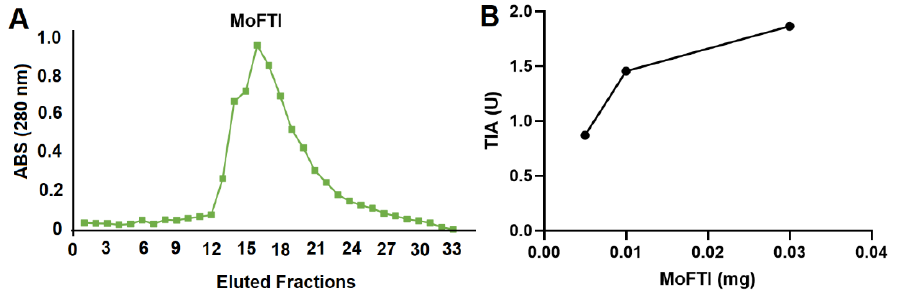
Figure 2. Isolation of MoFTI. ( A ) Affinity chromatography of M. oleifera flower extract in Trypsin–Agarose column. The elution step with 0.1 M KCl-HCl pH 2.0 can be seen and fractions of 1.0 mL were collected. ( B ) Trypsin inhibitor activity (TIA) of MoFTI on bovine trypsin.